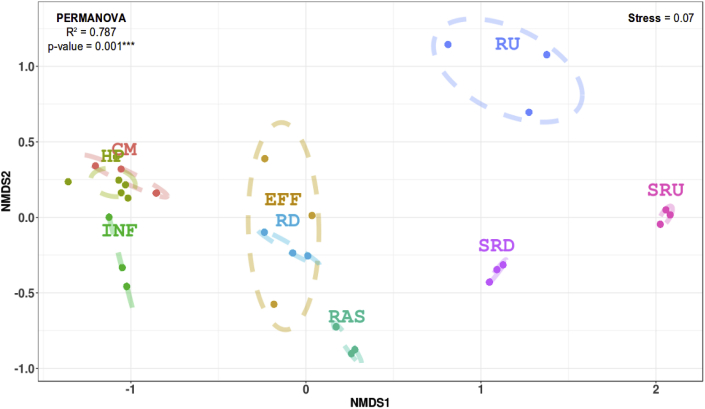
Non-metric multidimensional Scaling (NMDS) of a Bray–Curtis resemblance matrix among 30 samples obtained from wastewater network. Labels are as follows: CM = community wastewater, HP = hospital wastewater (HP_A and HP_B), INF = WWTP influent, RAS = return activated sludge, EFF = WWTP liquid effluent, RD = downstream river water column, RU = upstream river water column, SRD = sediment river downstream, and SRU = sediment river upstream.